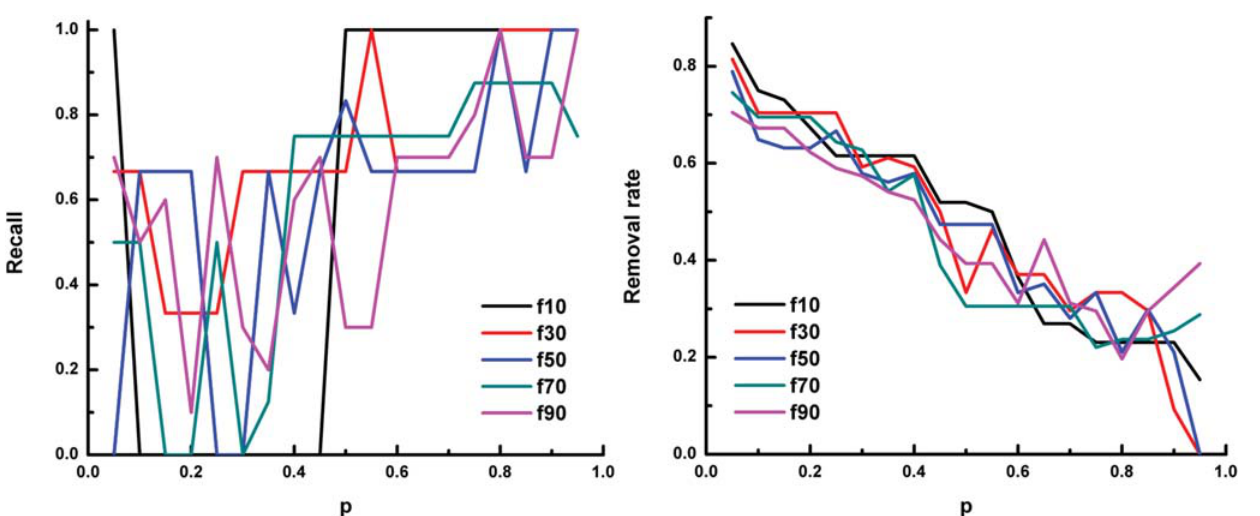
Fig 5. The recall and removal rate of prediction on Oct4-miRNA relationships using only known regulation between Oct4 and miRNA genes. In each panel, the x-axis denotes the parameter p of SVMlight. The y-axis denotes the recall (left panel) and the removal rate (right panel) of the prediction, respectively. f10 means 10% of the known positive examples are put into the unlabeled data,and f30, (cid:3)(cid:3)(cid:3) , f90 mean 30%, (cid:3)(cid:3)(cid:3) , 90% of the know positive examples are put into the unlabeled data, respectively.